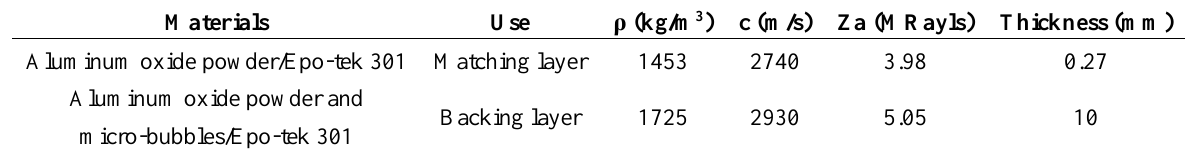
Figure 4. Schematic diagram of the 1-3 composite transducer. Table 2. Properties of the matching and backing